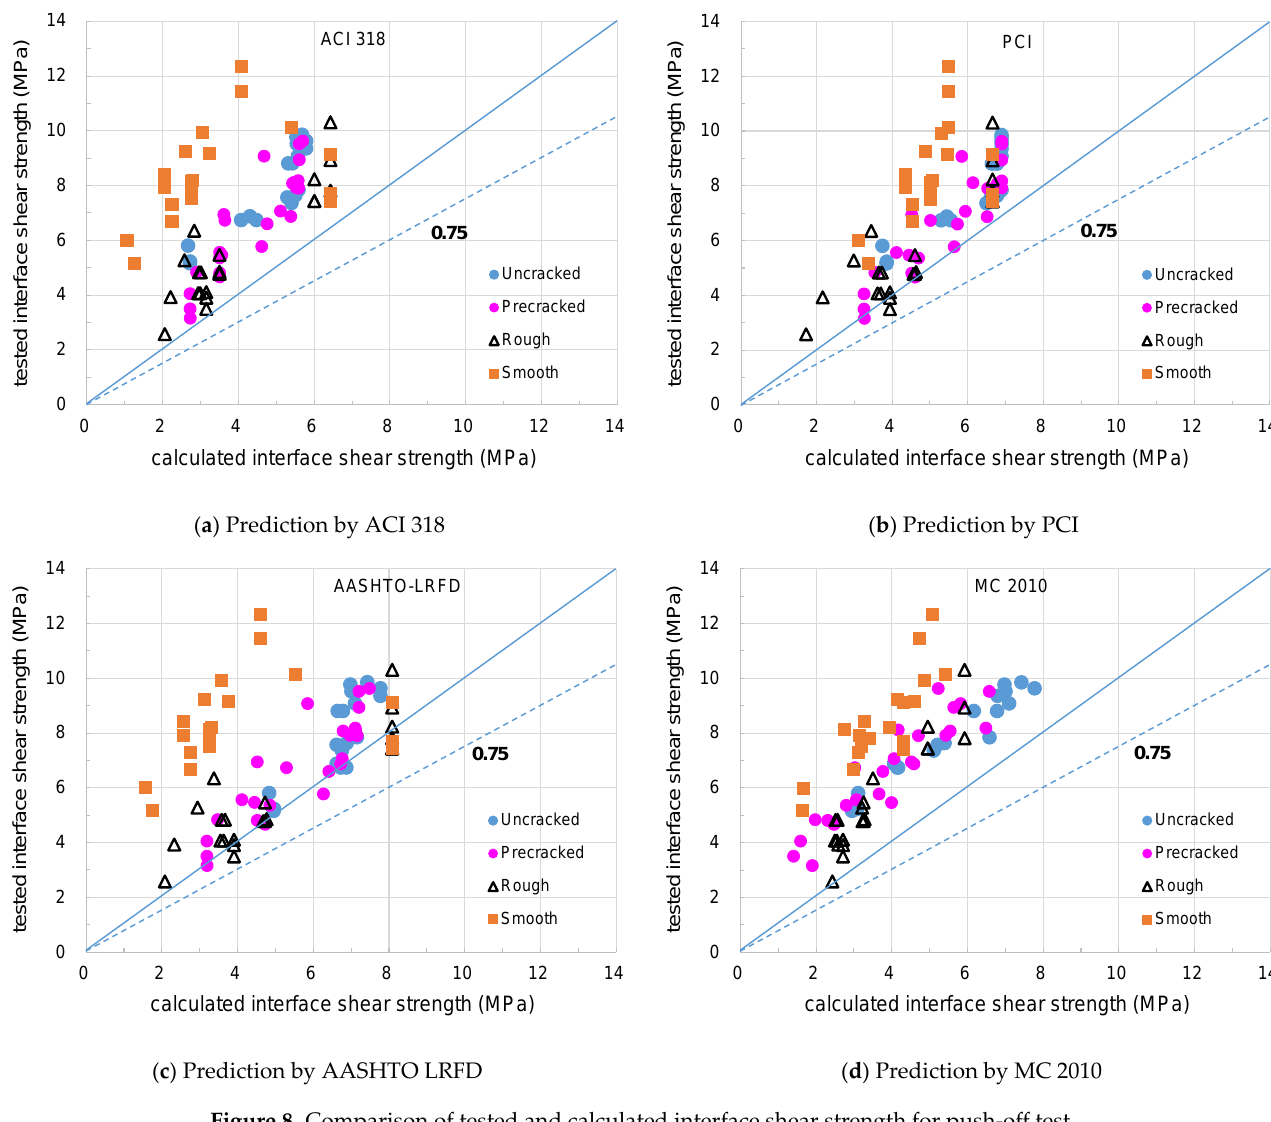
Figure 7. Effect of concrete strength and clamping stress on horizontal shear strength for push-off test.